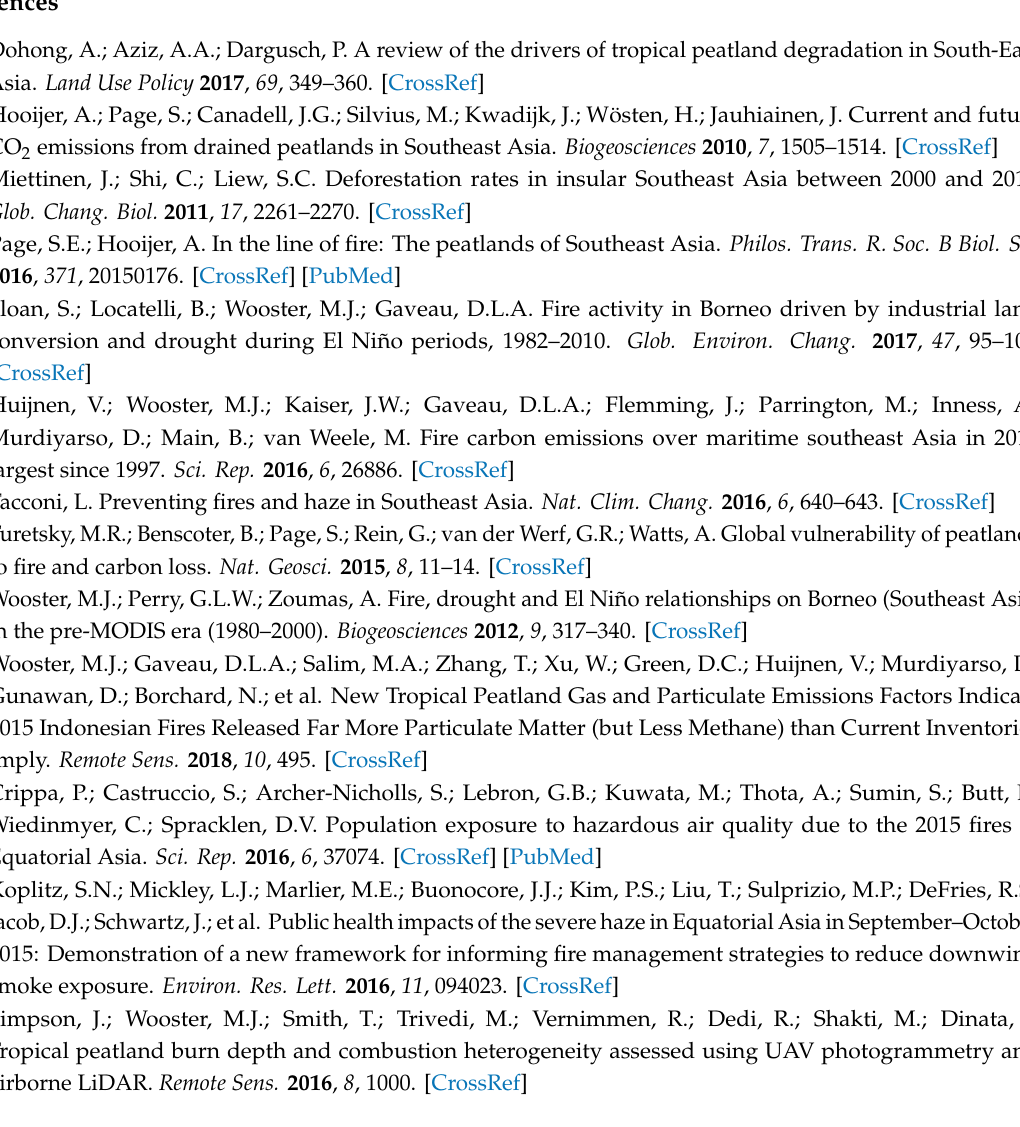
Figure A9. Boxplots of collocated SWIR spectral radiances for all AHI FRP product thermal anomaly containing pixels shown in Figure A8 binned based on whether the pixel meets the MWIR / LWIR spectral ratio threshold of 5.4 W m 2 sr − 1 µ m − 1 (W m 2 sr − 1 µ m − 1 ) − 1 or not. The boxplots follow the same conventions defined in Figure 5.